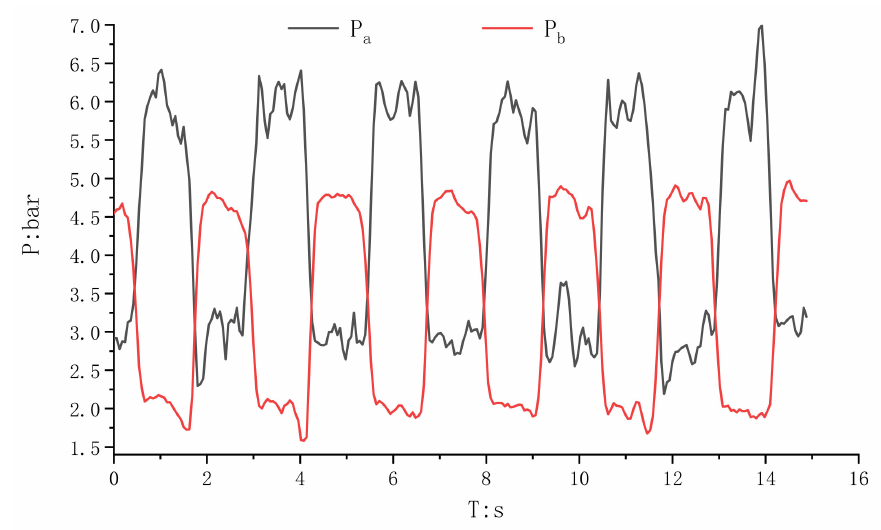
Figure 22. Pressure test curve of the two chambers of the hydraulic cylinder. P a denotes the hydraulic cylinder rod’s cavity pressure; P b denotes the pressure of the piston chamber of the hydraulic cylinder.